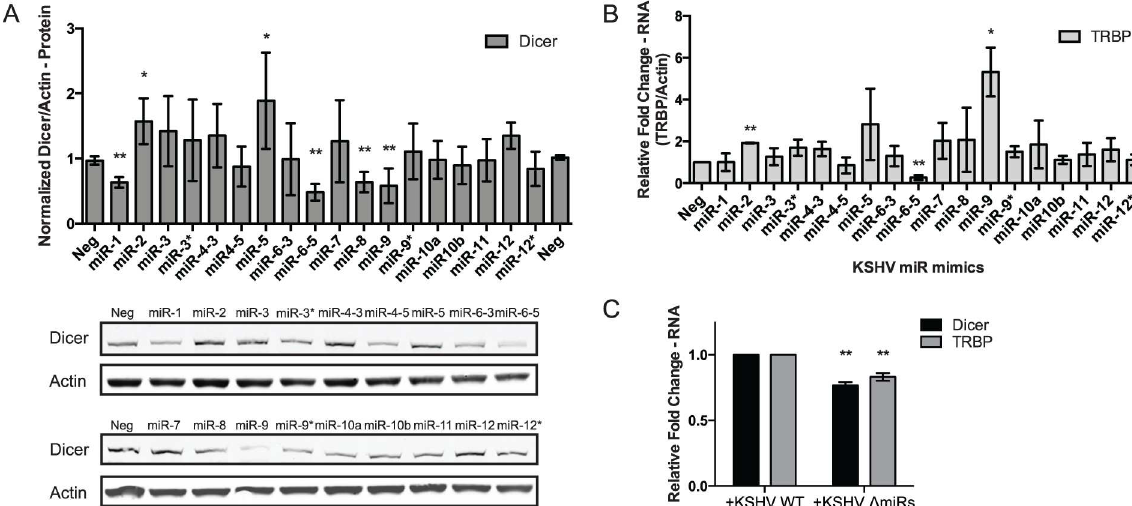
Fig 5. KSHV miRNAs increaseexpressionof miRNA biogenesis components Dicer and TRBP. (A) Dicer protein expression was determined by western blot from HUVECs transfected with individual KSHV miRNA mimics. The results are averagedfrom 4–5 replicatesand a representative western blot is shown. (B) TARBP2 RNA expressionwas determinedusing qPCR from HUVECs transfected with individualKSHV miRNA mimics. Results are shown relative to β -actin and normalized to the negativecontrol. For all graphs, results are shown as mean ± SD, N = 3. Significance was assessedusing a Student’s t test, * p (cid:20) 0.05, ** p (cid:20) 0.01. (C) Dicer and TRBP expressionwas measuredusing qPCR as in (B) from iSLK cells containinga WT KSHV genomeand a mutant containing a KSHV miRNA cluster deletion. N = 5. For all graphs, results are shown as mean ± SD. Significance was assessedusing a Student’s t test, * p (cid:20) 0.05, ** p (cid:20) 0.01. Numericaldata can be found in S1 Data.